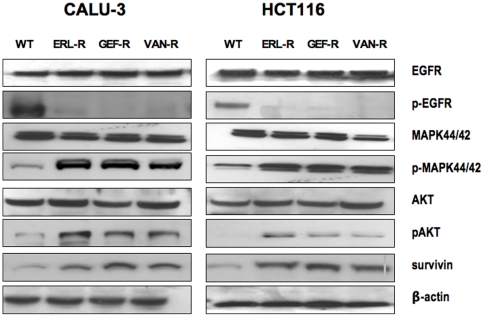
Analysis of EGFR downstream pathways in parental CALU-3 and HCT116 cells (WT) and in their TKI-resistant derivatives 8ERL-R, GEF-R, VAN-R).Western blotting analysis of EGFR and of down-stream signalling pathways in parental human CALU-3 and HCT116 cells (WT) and in their TKI-resistant derivatives (ERL-R, GEF-R, VAN-R). β-actin was included as a loading control.